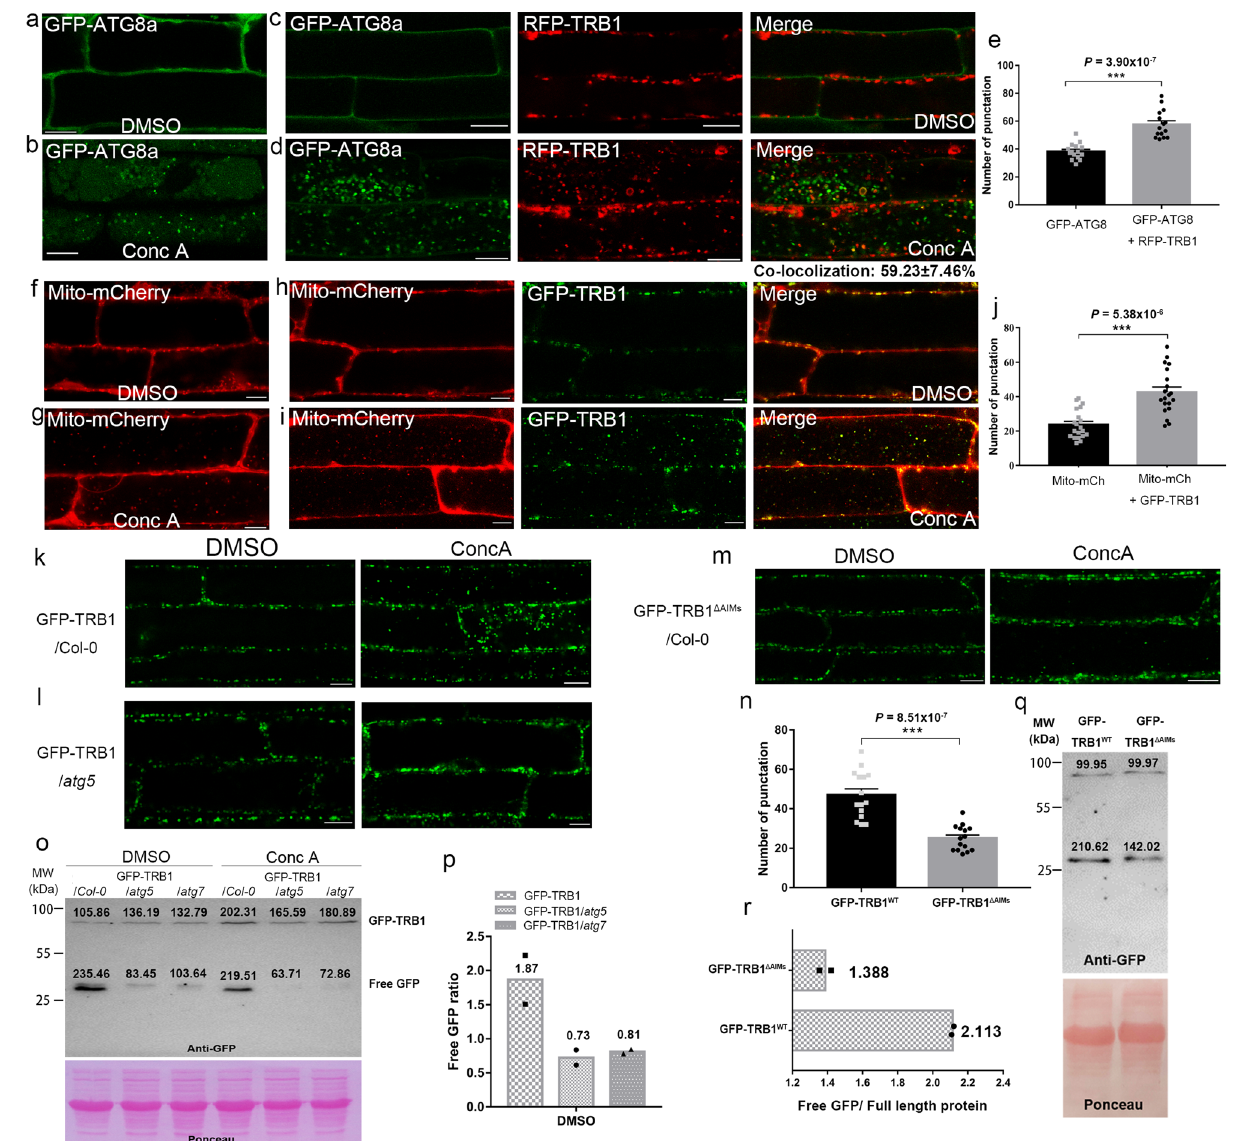
mitochondria through the autophagy machinery. a – d Arabidopsis plants expressing GFP-ATG8a or GFP-ATG8a+RFP-TRB1 grown in MS growth media with- out stress. After Conc A treatment, GFP-ATG8a labelled autophagosome structures were identi fi ed inside the vacuole ( b ); autophagosomes that contain mitochondrial signal (labelled by RFP-TRB1) are also abundant in cells expressing GFP-ATG8a and RFP-TRB1( d ).Incontrast,littlevacuolesignalwasseenincellstreatedwithDMSOas the control ( a , c ). e Quanti fi cations of autophagosomes numbers in the vacuole per fi eld(80 µ m×15 µ m)afterconcA. f – i ArabidopsisplantsexpressingMito-mCherryor Mito-mCherry + GFP-TRB1 grown in MS growth media without stress. After Conc A treatment, numerous mitochondria (either labelled with Mito-mCherry or co- labelled with Mito-mCherry + GFP-TRB1) accumulated in the vacuole ( g , i ). In con- trast, little vacuole signal was seen in cells treated with DMSO as the control ( f , h